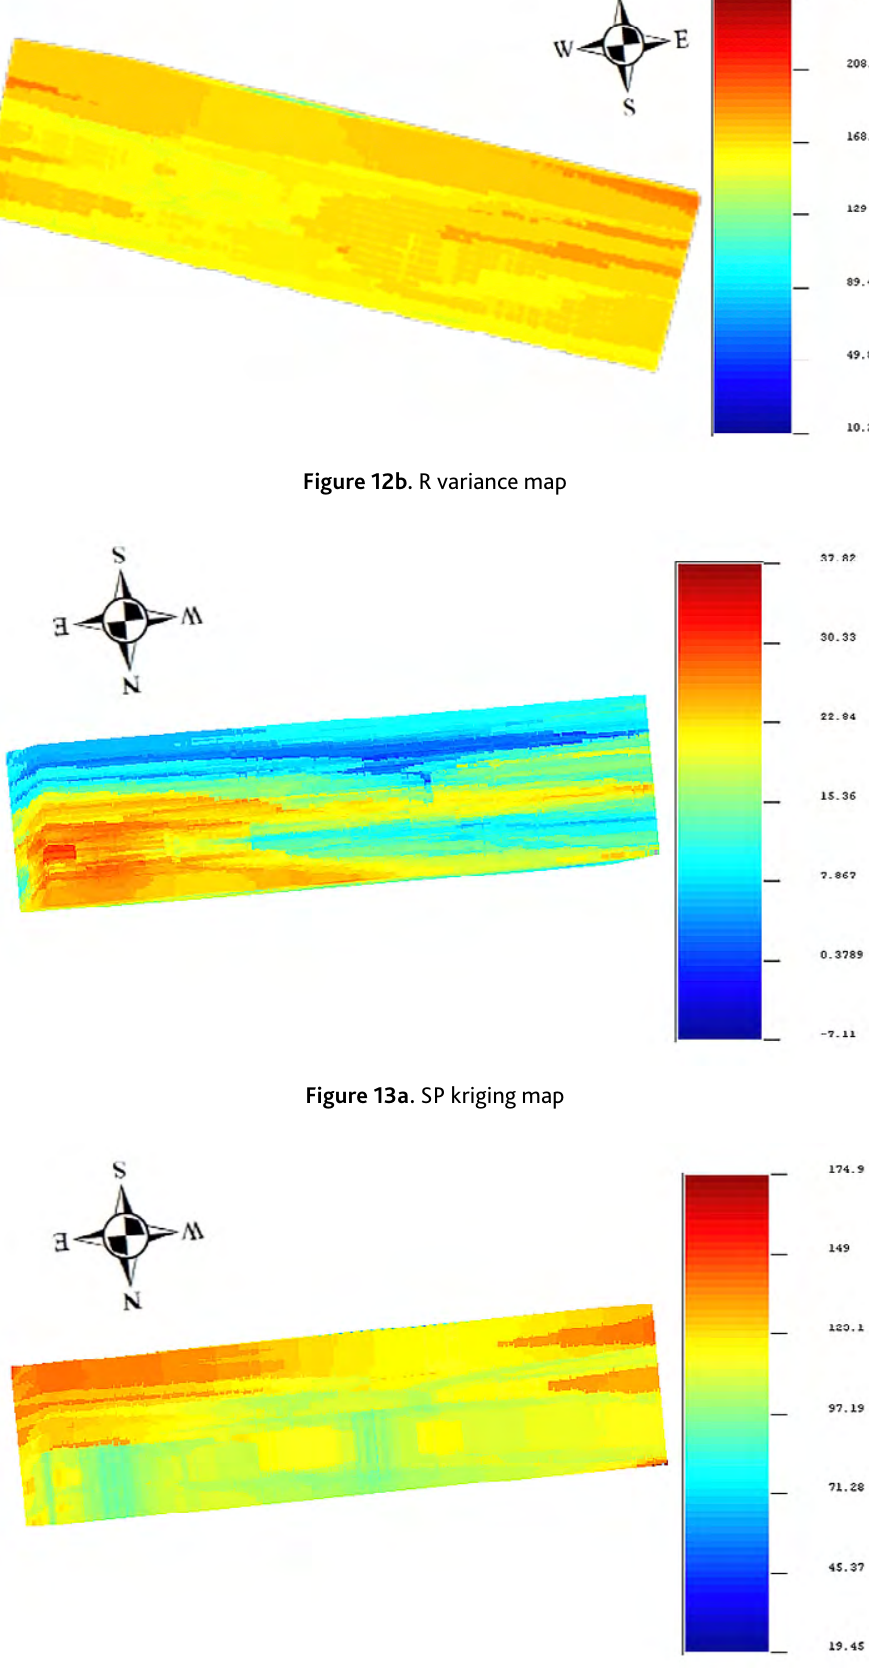
Figure 12b. R variance map